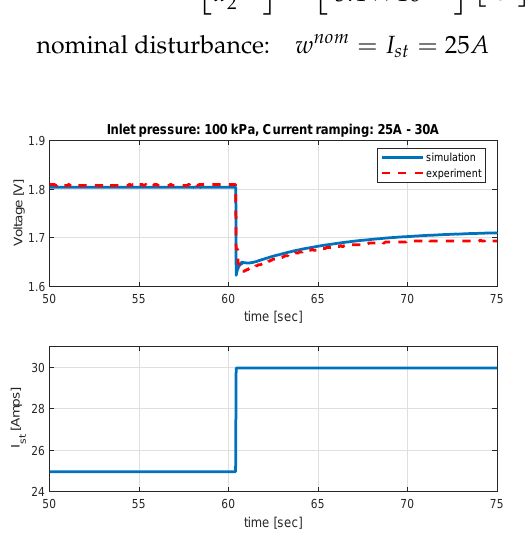
Figure 10. Transient response the PEMFC control-oriented nonlinear model: Zoomed 15 [ sec ] after current